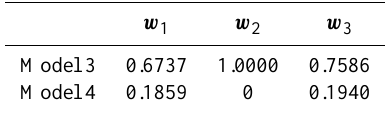
Table 3. The estimated weights of the weighted combination model (14) appearing in front of the corresponding imperfect model ten-